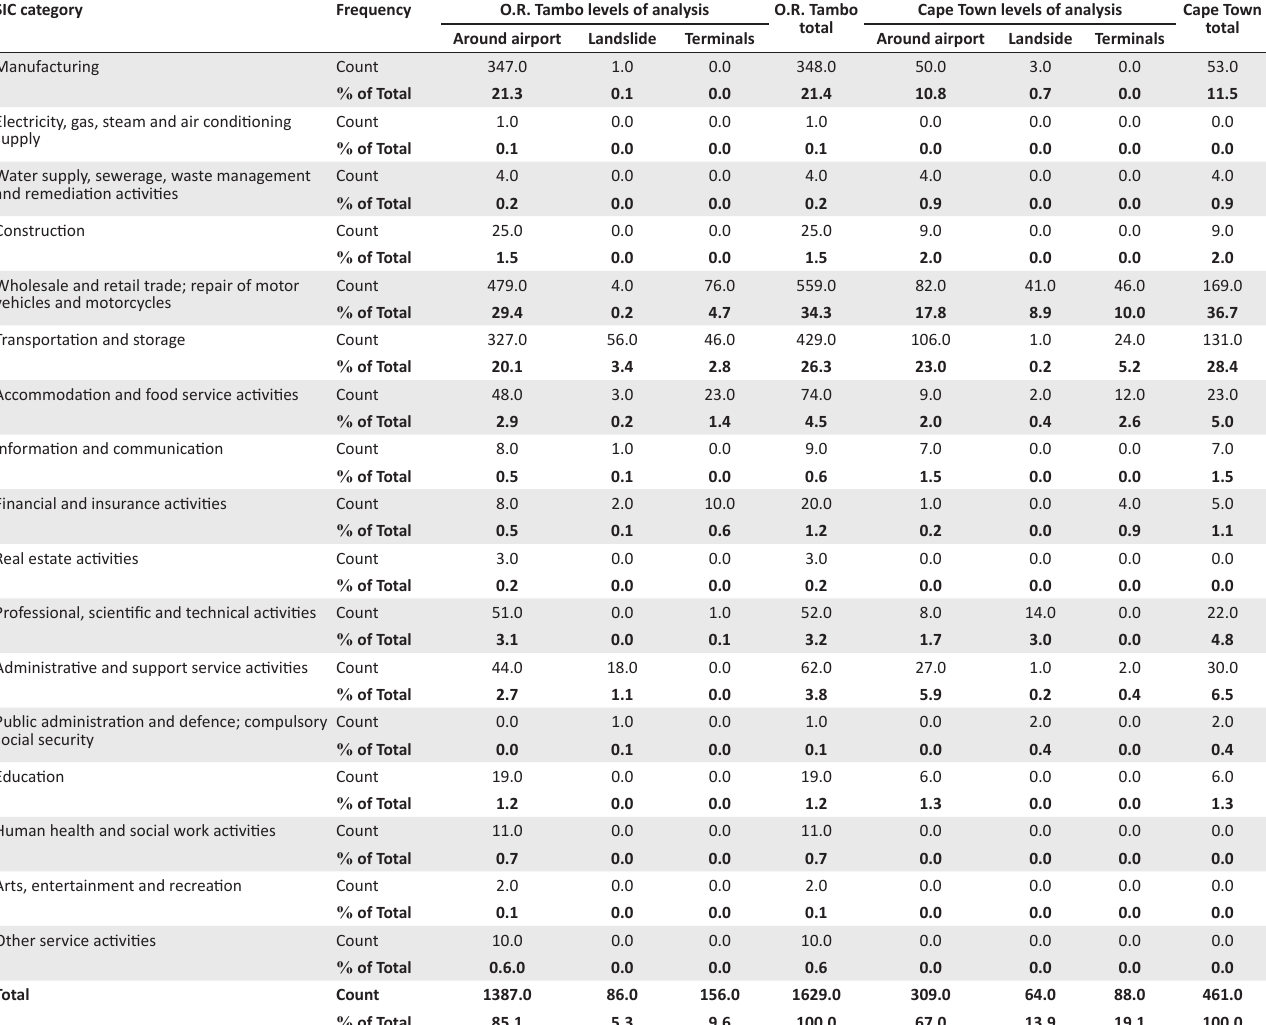
TABLE 1: Mix of O.R. Tambo and Cape Town airport-centric